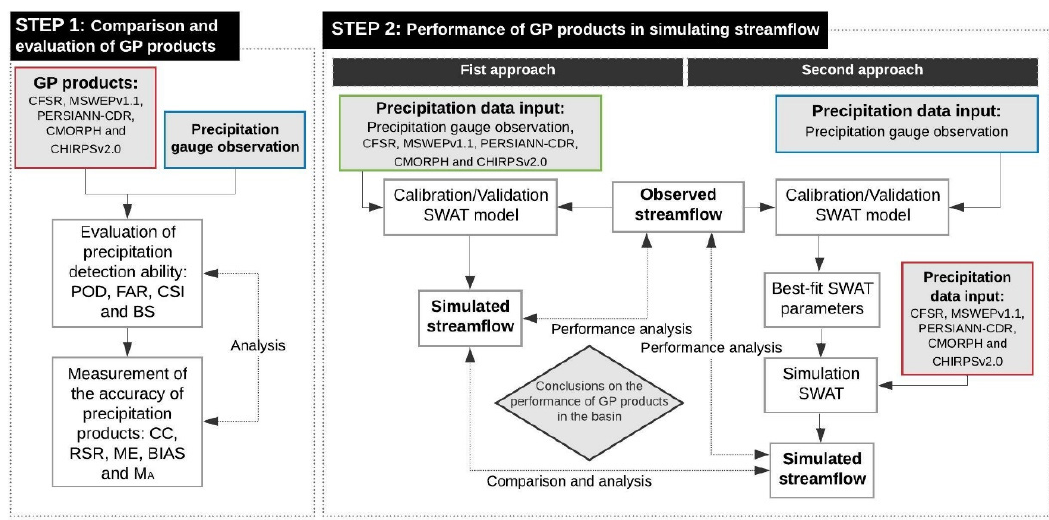
Figure 1. Flowchart for comparative study.